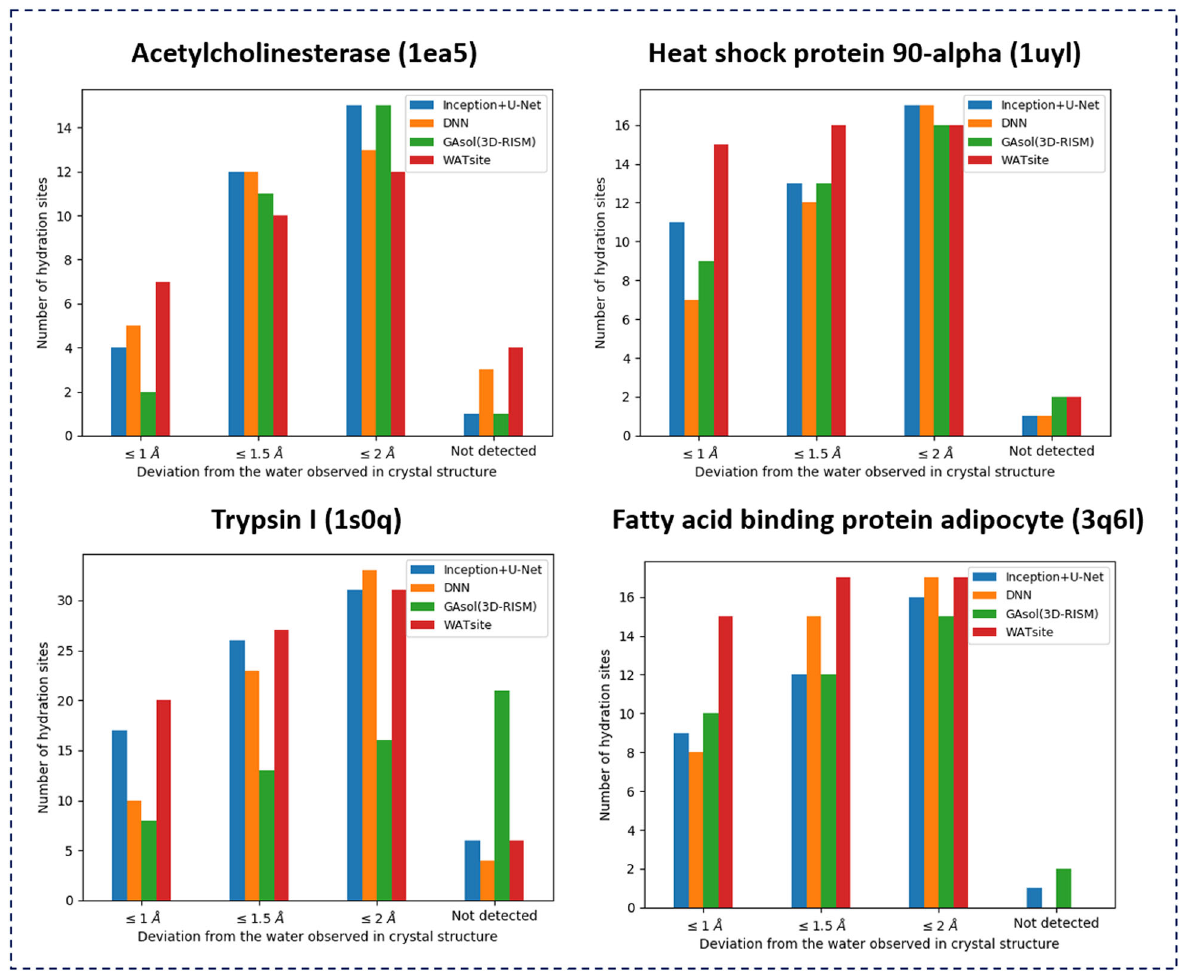
Fig. 10 Reproducing hydration sites observed in X-ray crystal structures. Comparison among Inception + U-Net, deep neural network (DNN) based on spherical-harmonics expansion, GAsol/3D-RISM, and WATsite. “ Not detected ” means no hydration site within 2 Å of X-ray water